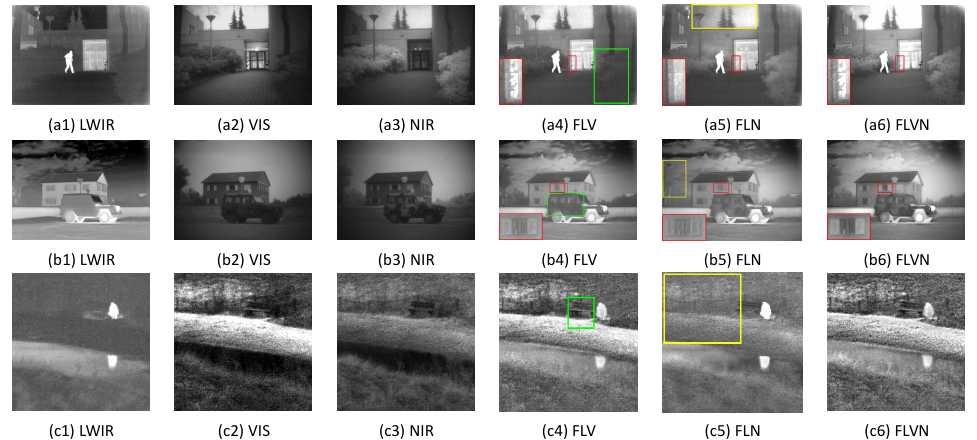
Figure 12. Fusion performance of the proposed fusion method on multiple-modality images with different spectra. LWIR: Long wave infrared image; VIS: Visible image; NIR: Near infrared image; FLV: Fusion image of LWIR and VIS; FLN: Fusion image of LWIR and NIR; FLVN: Fusion image of LWIR, VIS, and NIR. ( a1 ) LWIR, ( a2 ) VIS, ( a3 ) NIR, ( a4 ) FLV, ( a5 ) FLN, ( a6 ) FLVN, ( b1 ) LWIR, ( b2 ) VIS, ( b3 ) NIR, ( b4 ) FLV, ( b5 ) FLN, ( b6 ) FLVN, ( c1 ) LWIR, ( c2 ) VIS, ( c3 ) NIR, ( c4 ) FLV, ( c5 ) FLN, ( c6 ) FLVN.